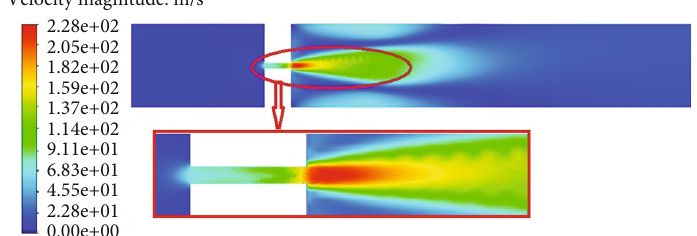
Figure 14: Cloud diagram and curve of fl ow fi eld velocity in restrictor.